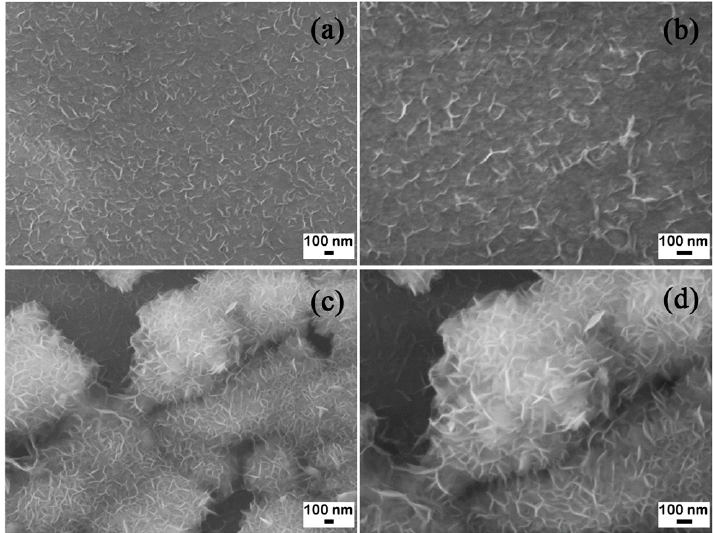
Figure 1. Scanning electron microscope (SEM) images of the Mg ribbon and Mg powder. ( a ) and ( b ) Mg ribbon; ( c ) and ( d ) Mg powder.